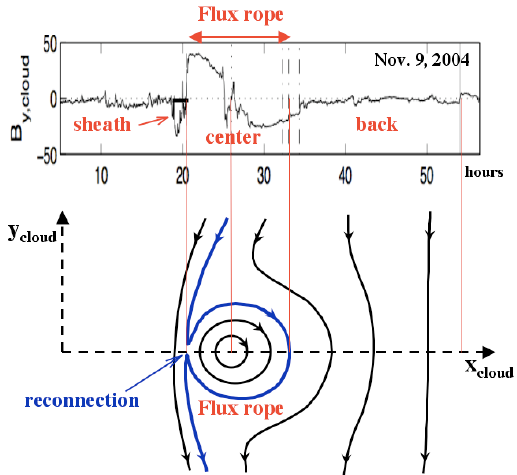
Fig. 9. Evidence of partial magnetic reconnection of a flux rope during its transit from the Sun to the spacecraft. Top panel: By cloud field component ( ≈ azimuthal component since the impact param- eter is small) for the 9 November 2004 MC (Dasso et al., 2007). A current sheet is theoretically expected to be present between two regions with different magnetic connectivities, such as between the flux rope and its surroundings. Then, the flux rope is defined by discontinuities of By cloud and the same azimuthal flux before and after the center ( By cloud is the dominant field component at the flux rope border). In the back of the flux rope an extended region of low but coherent field is present. This “back” region was probably belonging to the flux rope initially ejected from the Sun, but recon- nection in the front with the overtaken magnetic field connected it to the solar wind (bottom panel). Then, the reconnected flux became progressively swept behind the faster flux rope. The consequence of the frontal reconnection is an extended region in the back of the MC with a weak field having low fluctuations (thus different from the solar wind field).